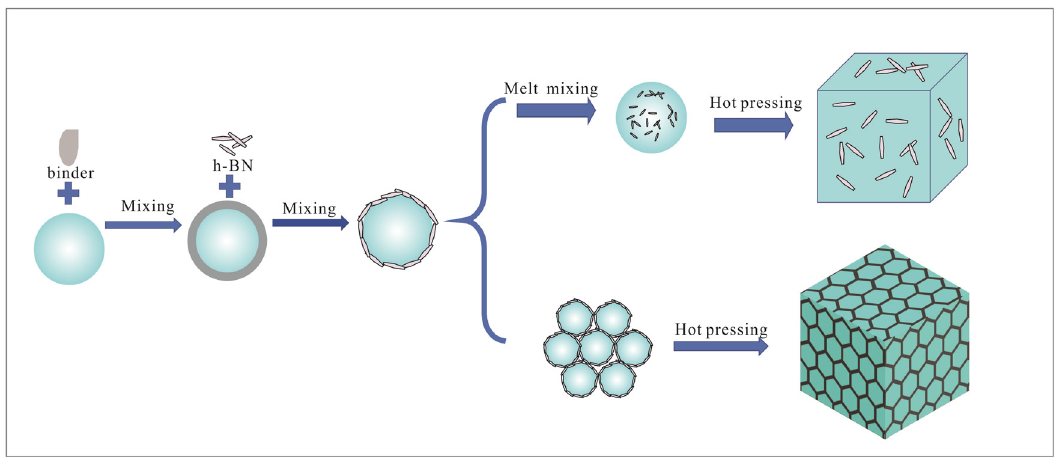
Figure 1: Schematic illustration of the thermally conductive composites fabrication procedure.